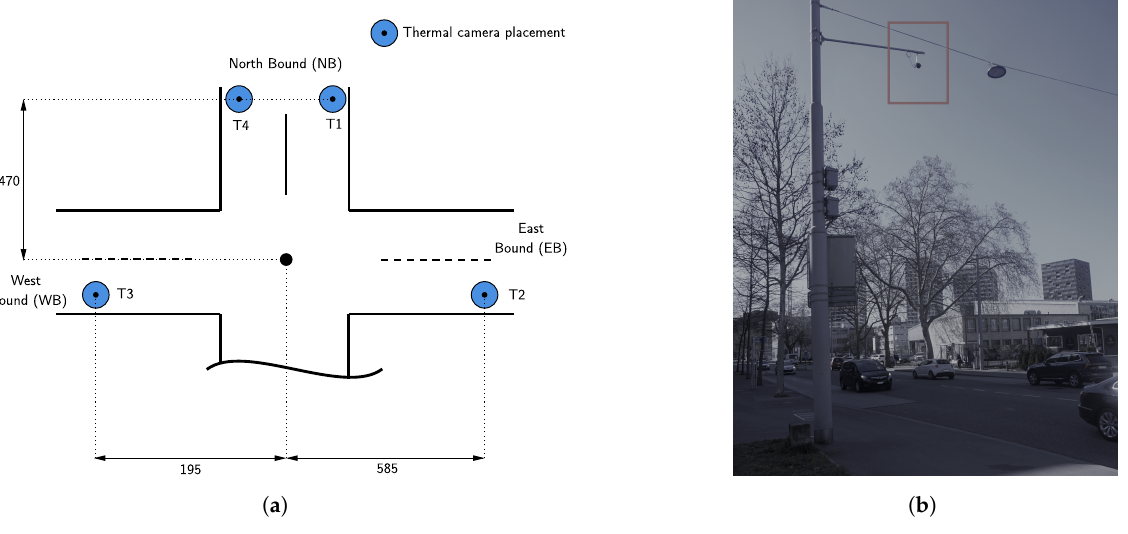
Figure 4. Thermal camera set-up: ( a ) four mounted thermal cameras and distances from the inter- section center (in meters) capturing traversing traffic (T1–T4), ( b ) example of an overhead mounted thermal